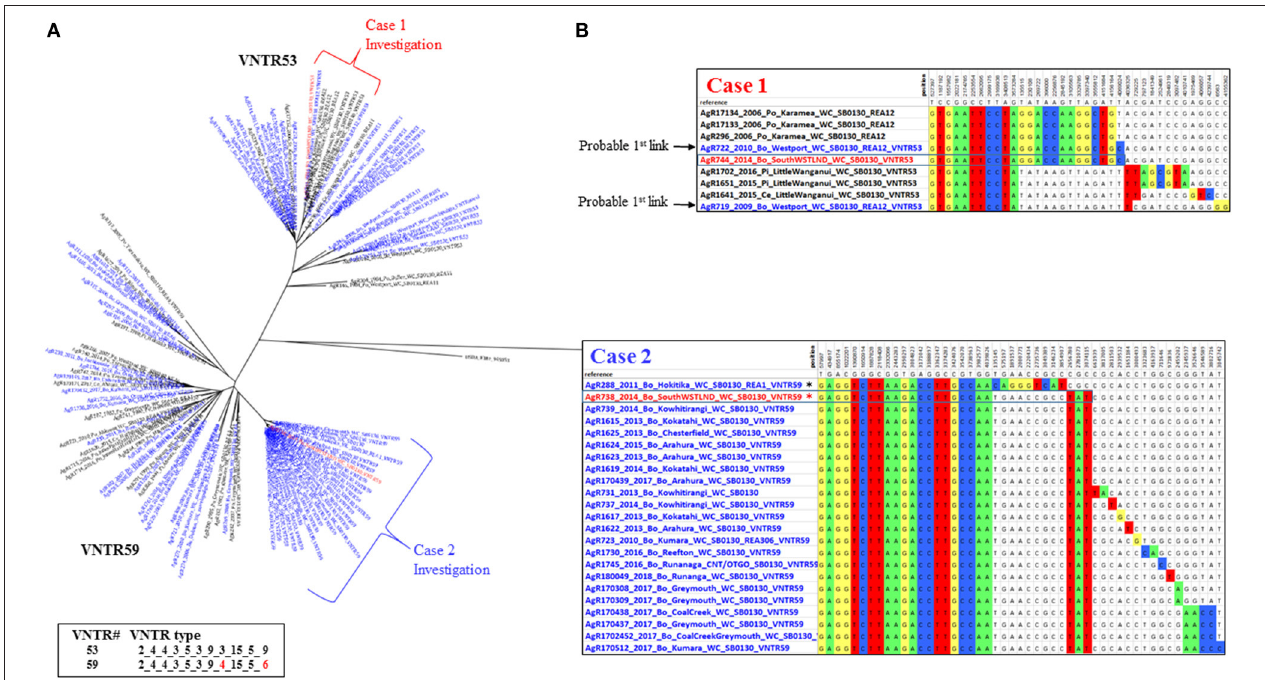
FIGURE 4 | Multiple South Westland herd infections. (A) Radial ML Phylogram illustrating the genetic relationship of the two types of M. bovis isolates detected during a South Westland breakdown investigation, to other type VNTR59/REA1/REA6 and VNTR53/REA11/REA12 M. bovis isolates in the database. Metadata for isolates from this herd are colored red, other livestock metadata are colored blue and wildlife metadata black. Brackets indicate close relatives of the breakdown isolates and are also described in the SNP table in (B) . Also shown are the two different VNTR types, with numbering as described in the legend for Figure 3 . (B) SNP tables illustrating the relationship of each type to its closest relatives. The coloring and numbering in this tables is as described in Figure 3 . SNPs detected in the case 1 and in case 2 isolates are boxed within the table. The asterisk in the case 2 table indicates an isolate (AgR288) that was ruled out as a possible source of infection by this investigation.